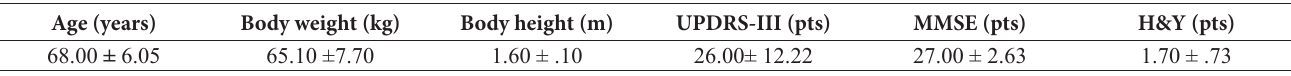
Table 1. Means and standard deviations of characteristics of patients with PD. UPDRS III: motor component of the Unified Parkinson’s Disease Rating Scale; MMSE: Mini-Mental State Examination; H&Y: